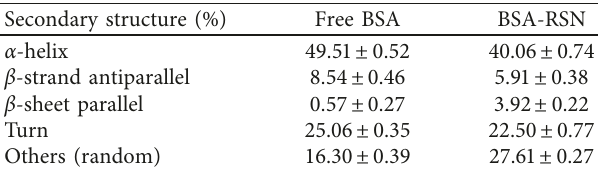
Table 8: CD spectral results for estimating the percentage of the secondary structure of BSA before and after interaction with RSN.